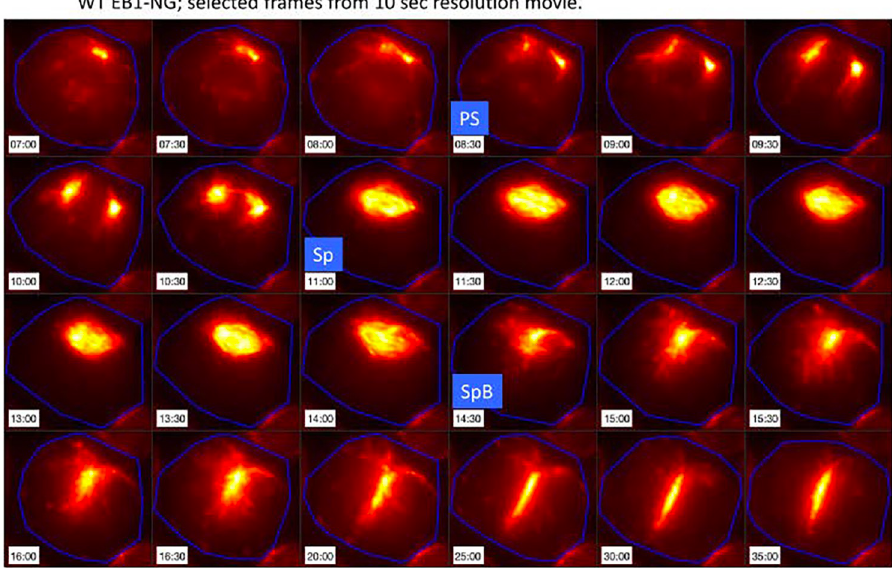
Fig 6. Live cell time-lapse of wild-type EB1 : NG-TG cells with 10-sec. intervals. Live cell time-lapse with 10-sec. intervals acquired with microscopy method 2 (see Methods section). EB1-NG signal in orange. PS: pole separation. Sp: spindle formation. SpB: spindle